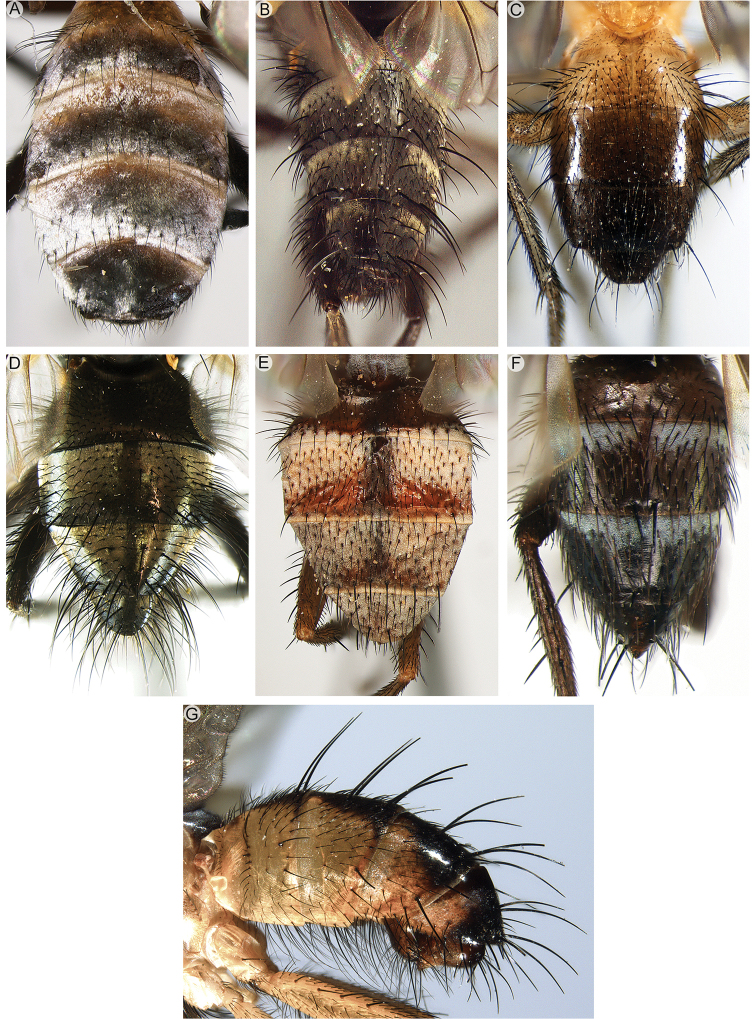
Rhinophoridae, abdomen. AMelanophora
basilewskyi ♂ (Kenya) BOplisa
tergestina ♂ (Italy) CParazamimus
congolensis ♂ (Burundi) DRhinomorinia
sarcophagina ♂ (Italy) ETromodesia
angustifrons ♀ (Israel) [paratype] FVentrops
stuckenbergi ♂ (Namibia) [holotype] GQueximyia
flavipes ♂ (South Africa). A–F dorsal view G lateral view.